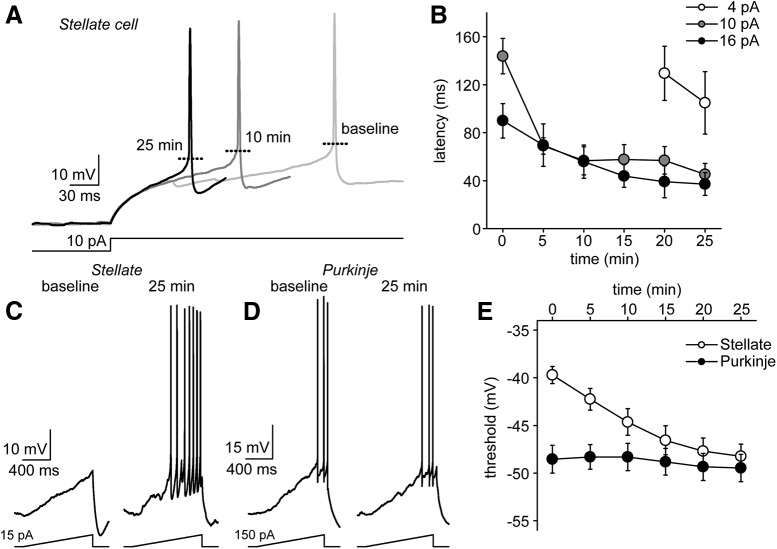
Excitability increase is underpinned by decrease in spike latency and hyperpolarization of AP threshold. A, First APs fired by a SC in response to 10-pA current step at three different time points: 1, 10, and 25 min after breakthrough. The spike latency in response to the step decreases substantially over the course of the recording. B, Summary plot of spike latencies for multiple step amplitudes over the course of a 25-min recording (n = 11 cells). C, Example current-clamp responses evoked by ramp protocol at baseline (left) and after 25 min (right) in a SC (patch #150129p2). D, Same for an example Purkinje cell (patch #141010p5). E, Summary plot depicting change in AP threshold over time in stellate (n = 11 cells) and Purkinje cells (n = 6 cells).